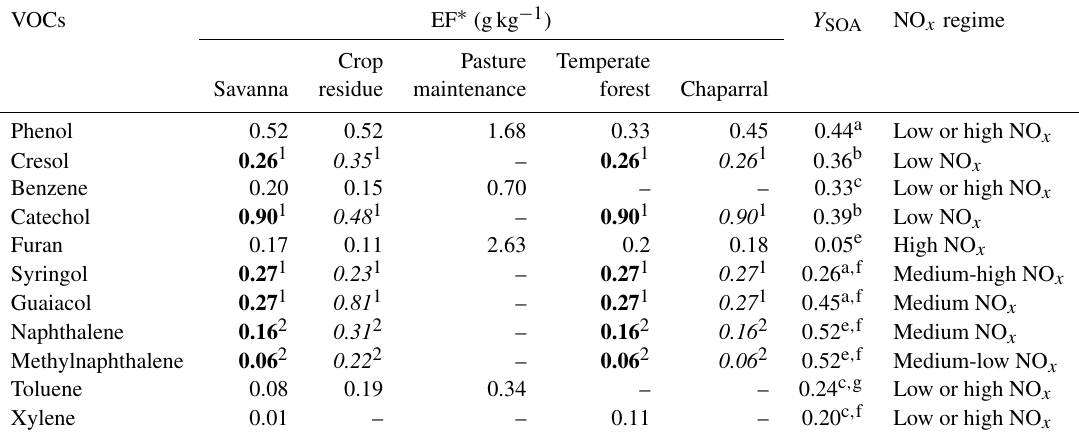
Table A1. The VOCs that are SOA precursors and their emission factors (EFs) and SOA yields. EFs from Akagi et al. (2011) are in regular font, ERs from Stockwell et al. (2015) are in italic font, and EFs in bold font are deduced from the assumption considering that temperate forest and savanna have the same EF as